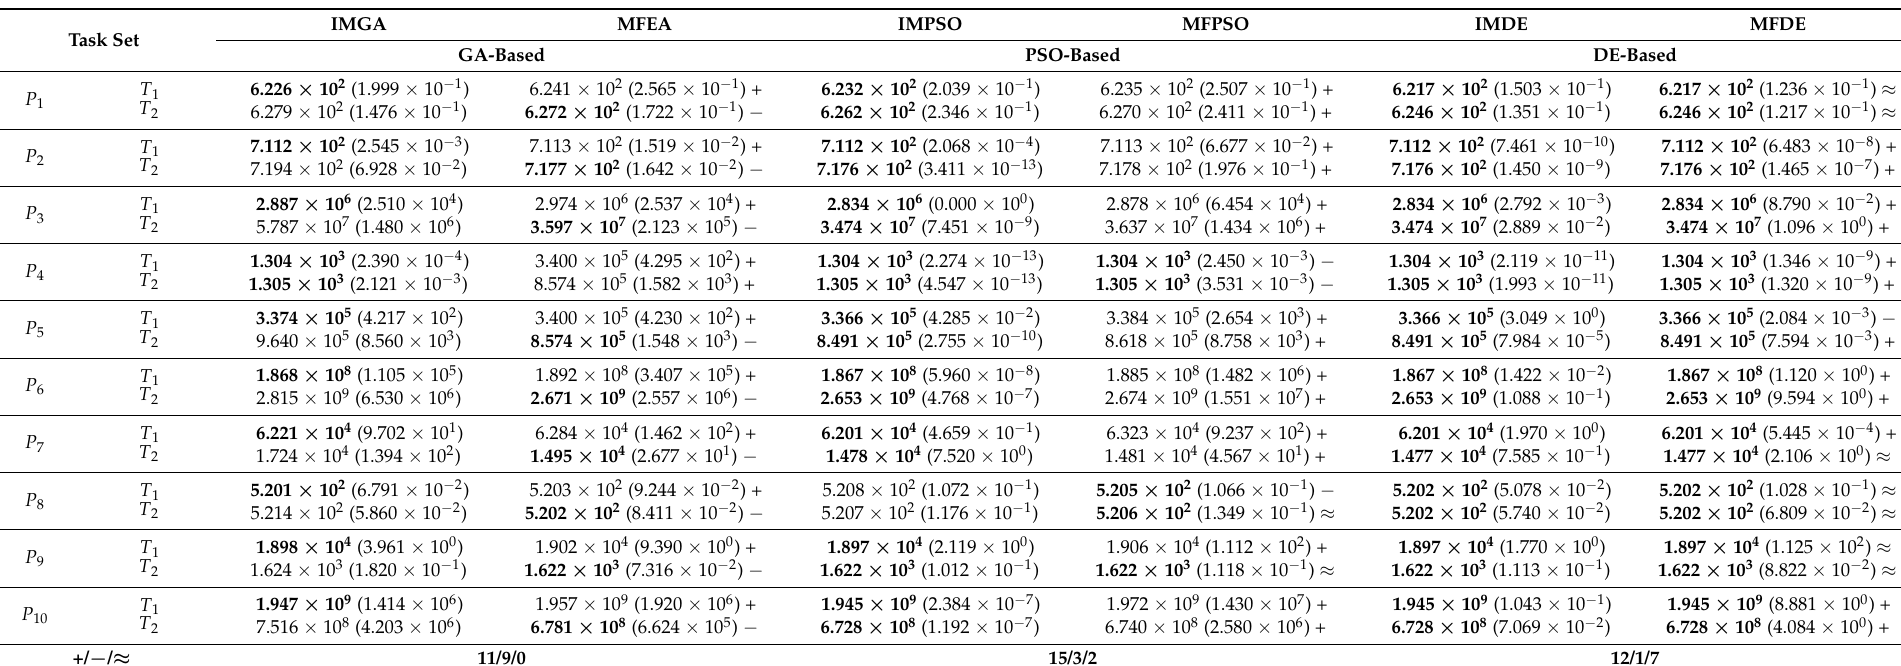
Table 5. The mean and standard deviation (in brackets) of the best achieved fitness values in test Suite